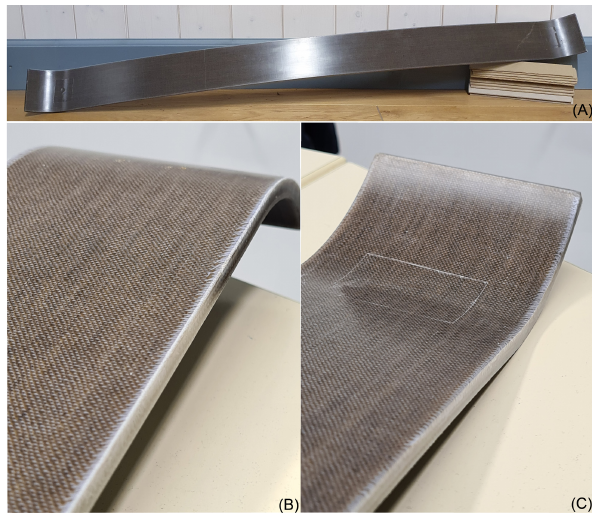
Figure 15. Prototype of a flax fibre-reinforced leaf spring of a bogie of a narrow-gauge railway produced by RTM, ( A ) overview, ( B , C ) detailed images (width of the leaf spring: 90 mm, length: 1170 mm).